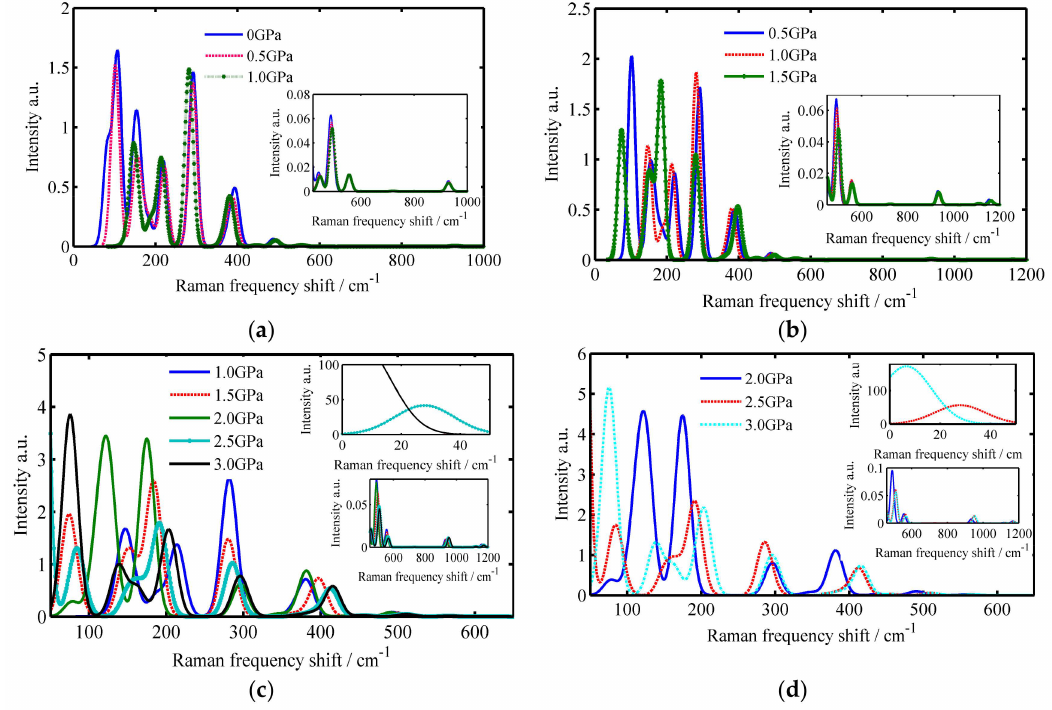
Figure 7. The Raman spectrums of Pb 4 + -doped β -SiO 2 crystal under di ff erent pressure and temperature.